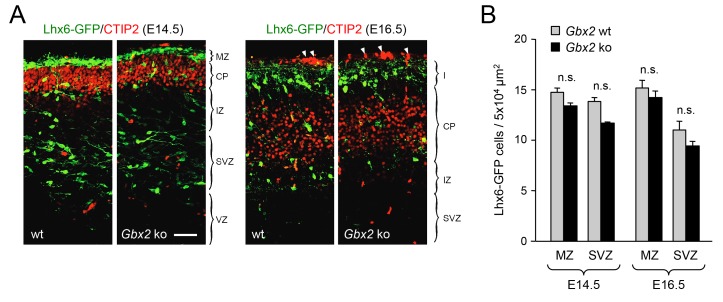
Normal proportion of GABAergic interneurons in superficial versus deep routes of tangential migration in Gbx2 knock-out embryos.(A) Lhx6-GFP+ interneurons (green) in prospective somatosensory cortex of newborn wild type (wt) and Gbx2 knock-out (ko) mice at E14.5 and E16.5 combined with immunostaining against CTIP2 (red). Arrow head indicate unspecifically labeled blood vessels above cortex. Scale bar, 50 µm. (B) Quantification of Lhx6-GFP+ interneurons in the marginal zone (MZ) and subventricular/intermediate zones (SVZ/IZ) in Gbx2 knock-out and wild type embryos at E14.5 and E16.5. Results are expressed as average ± SEM (n.s., not significant [p > 0.05]; N = 6 mice per group).